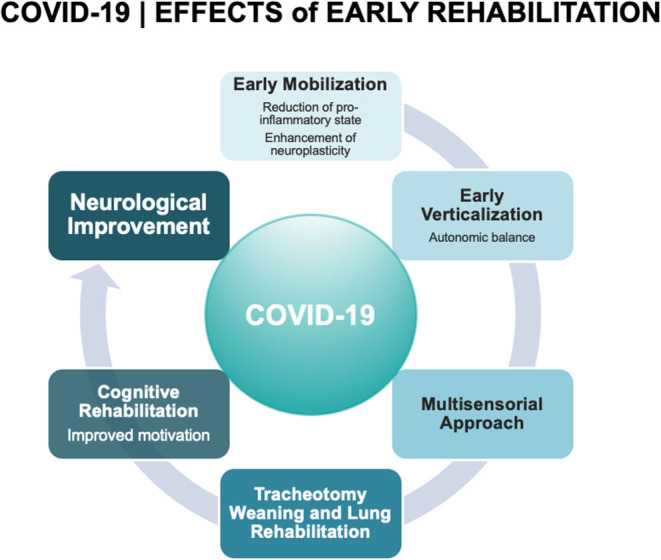
Covid-19 effects of early rehabilitation.